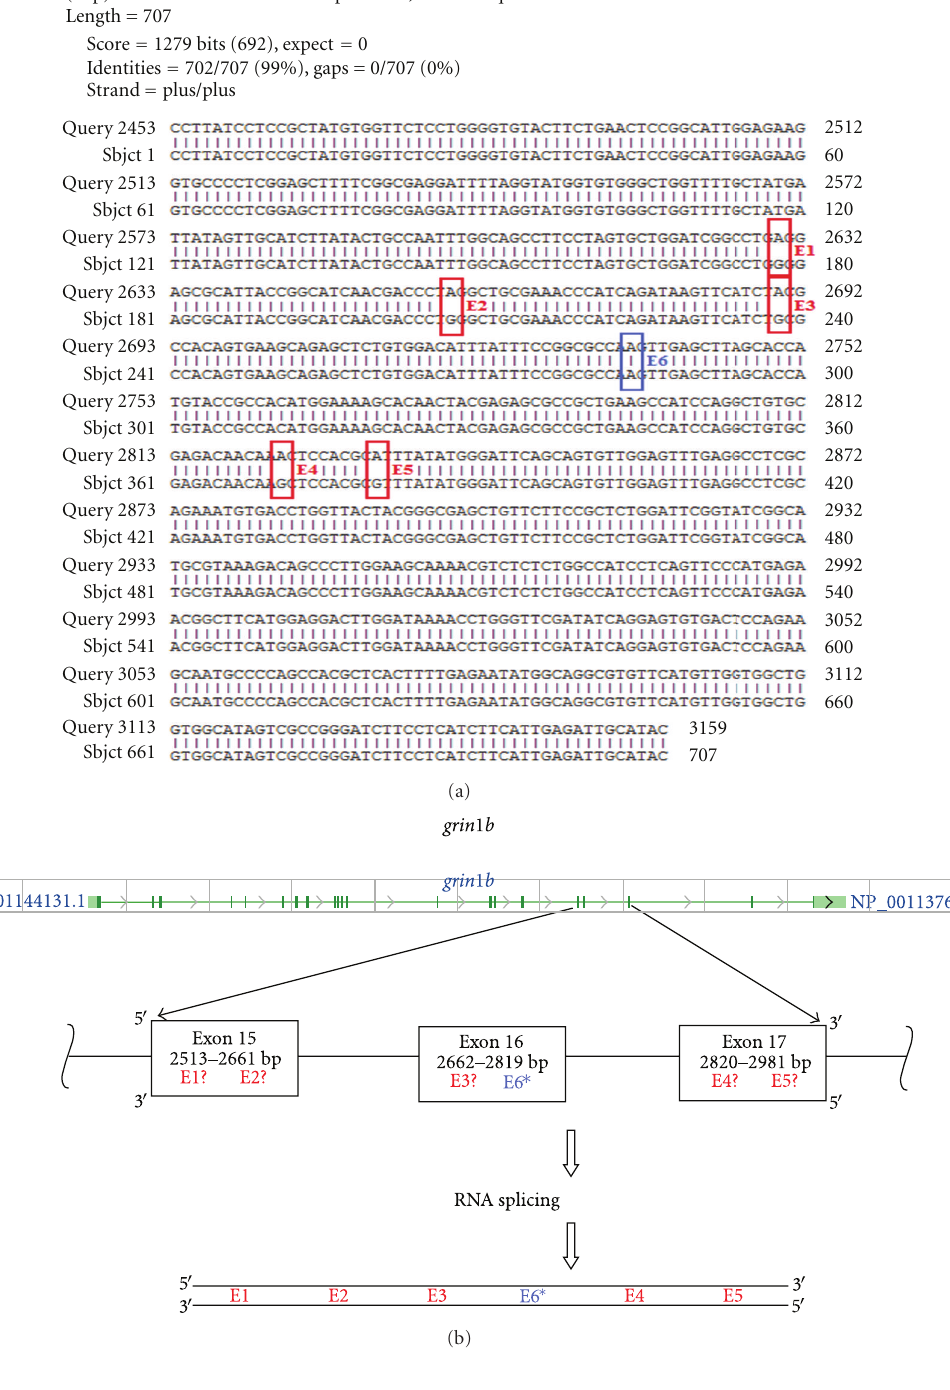
Figure 1: Alignments. A schematic showing the relative (a) and genomic (b) locations of the 5 initially predicted RNA editing events obtained from BLAST searches within the grin1b transcript. Predicted sites E1–E5 are located in a stretch of about 468 bases in the mature mRNA corresponding to exons 15 through 17 (as per zfin.org, ensembl.org). Schematic corresponds to NCBI representation of the grin1b gene in 2011. ∗ The E6 site was discovered only after direct